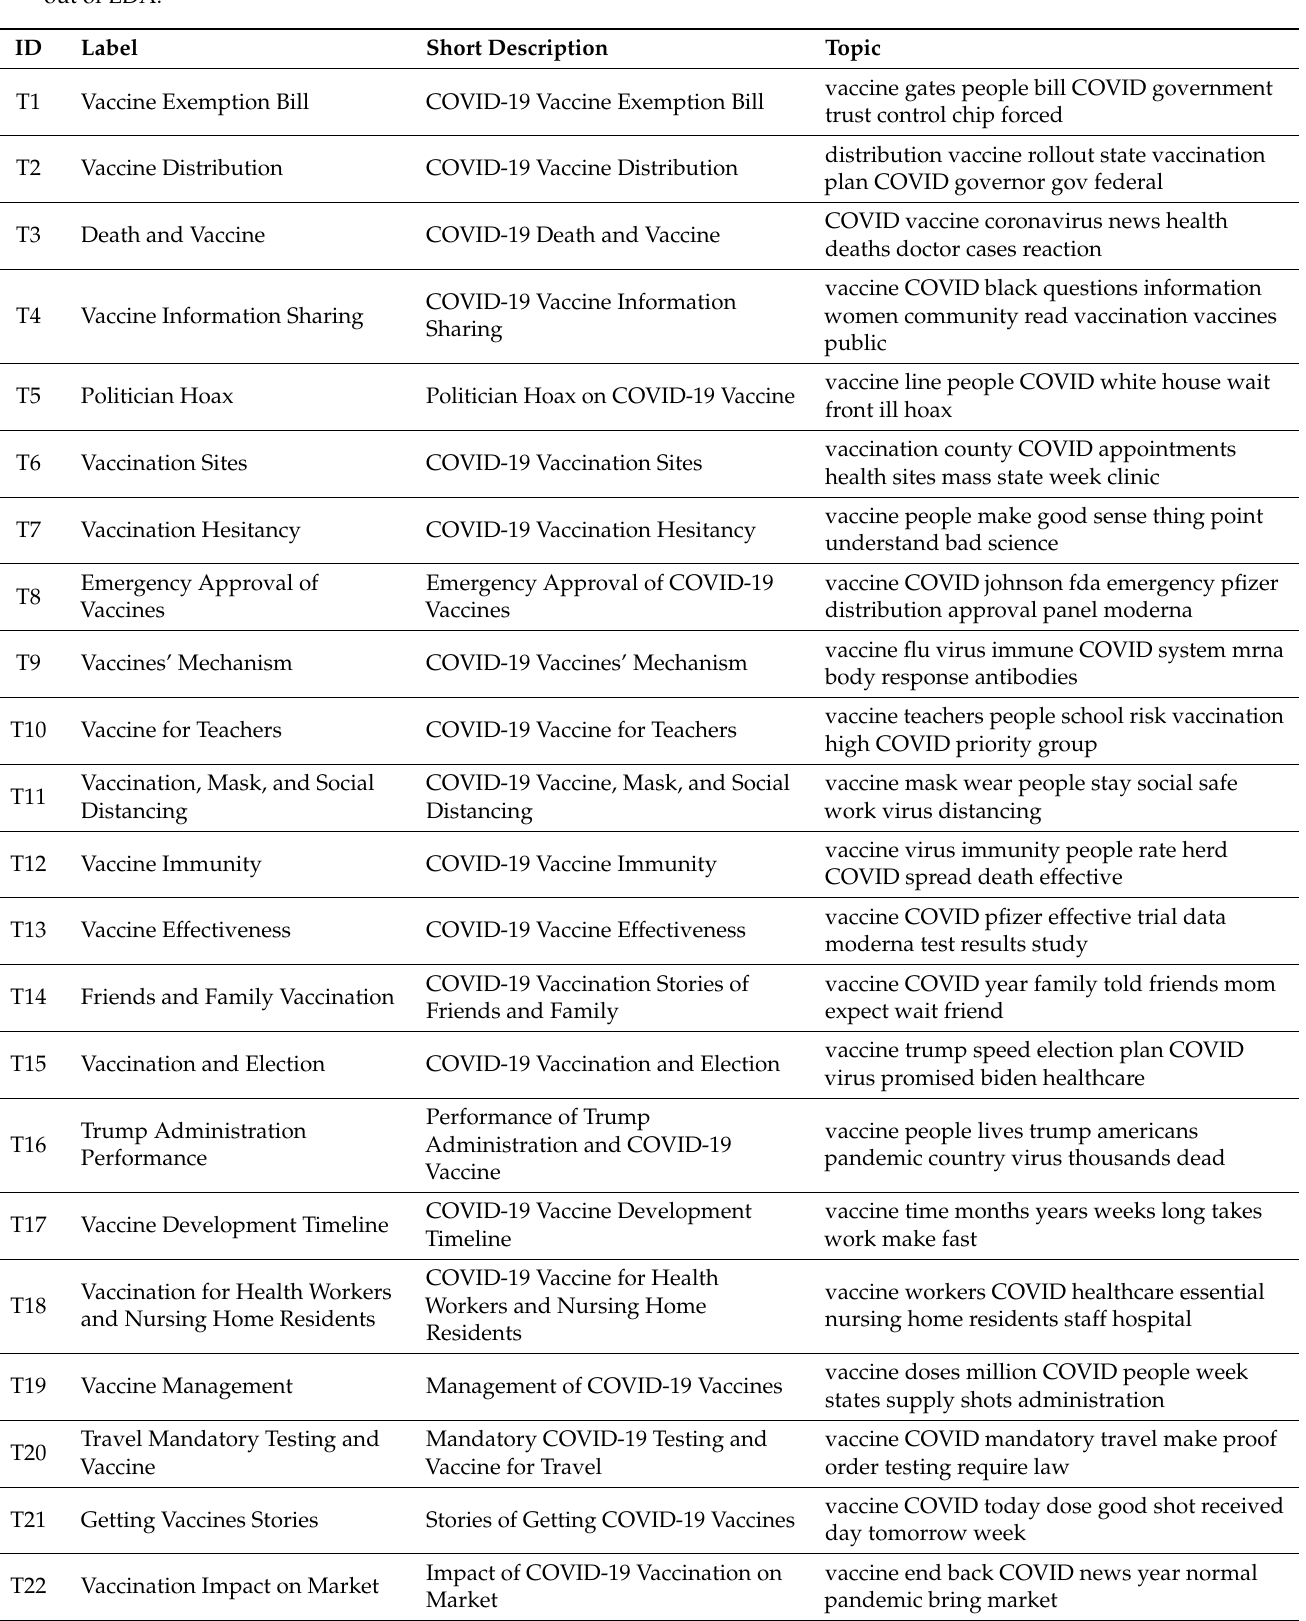
Table 1. Topics of COVID-19 related tweets and the label and short description of topics. The order of topics is based on the out of